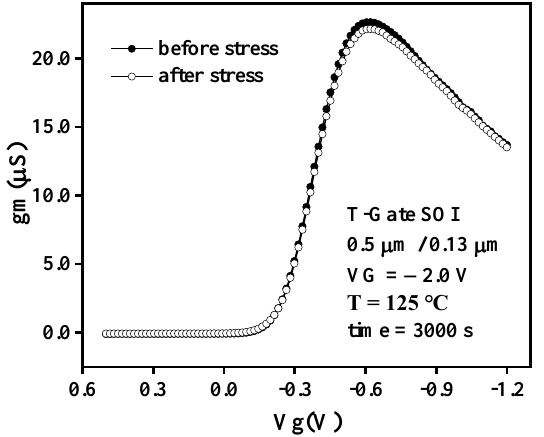
Figure 6. Transconductance characteristics of Core PMOS before and after NBTI stress.